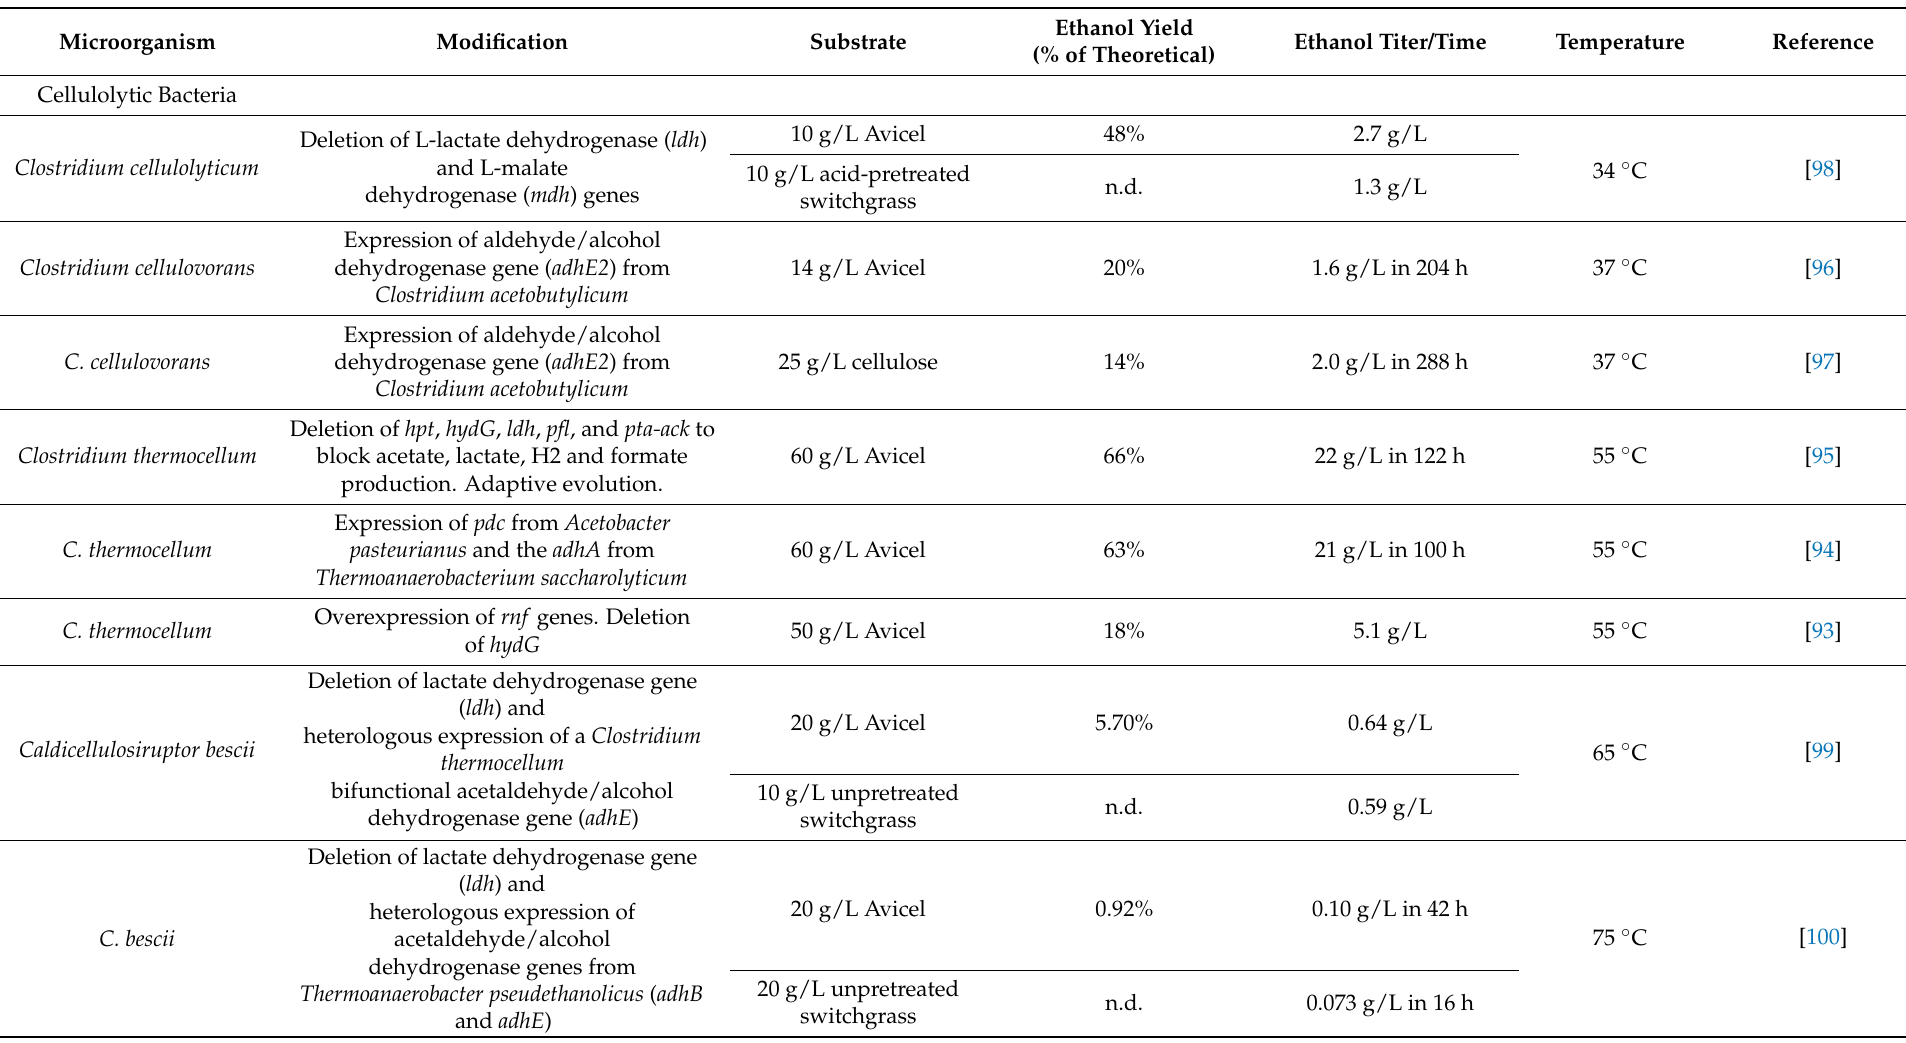
Table 1. Different strategies and outcomes of modified cellulolytic microorganisms for consolidated bioprocessing. Ethanol yield was calculated (when data was available) as the ratio of grams of ethanol produced by the total of potential fermentable sugars in the medium and presented as percentage of the theoretical yield 0.511 g/g. N.D.: not